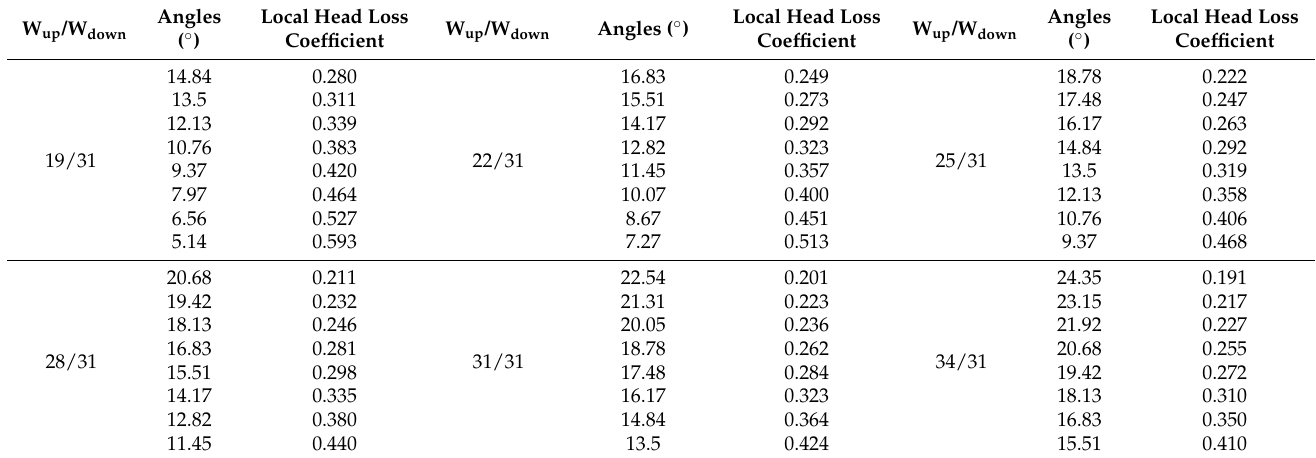
Table 7. Weir head under the simulated working